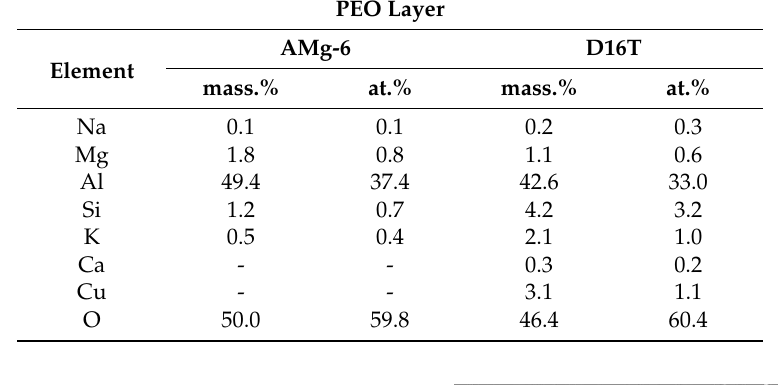
Table 3. Element composition of the PEO layers synthesized on АМg-6 and D16T alloys.